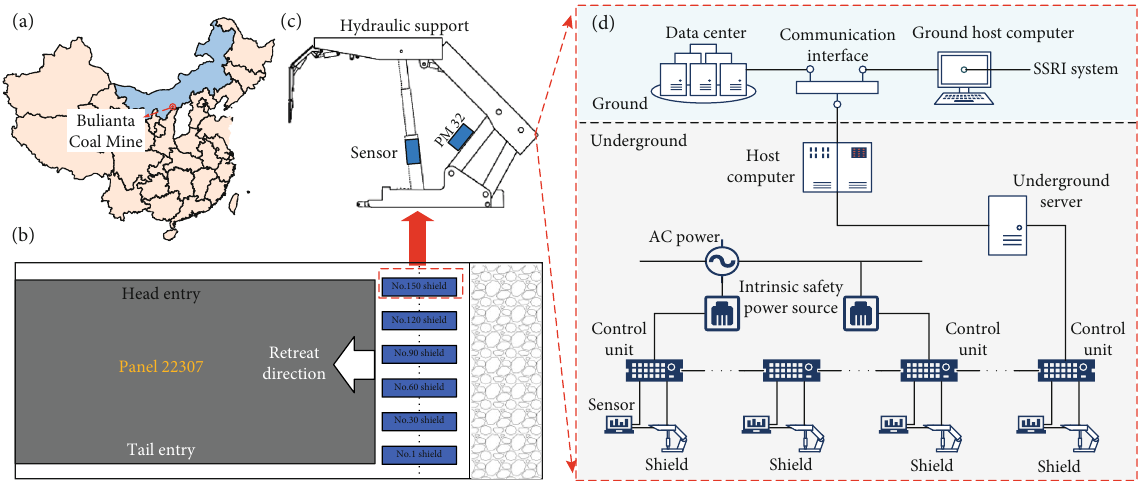
Figure 1: Description of the study area: (a) location of the Bulianta Coal Mine; (b) positions and numbers of shields; (c) positions of pressure sensors and PM32 controllers; (d) data acquisition and transmission method and SSRI system.